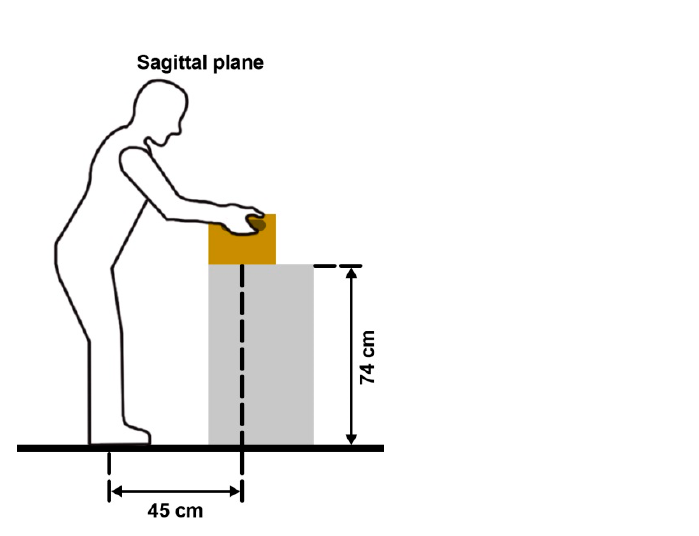
Figure 2. LIFTING task according to the NIOSH Lifting Equation. Table 1. The environmental parameters tested in the experiments.